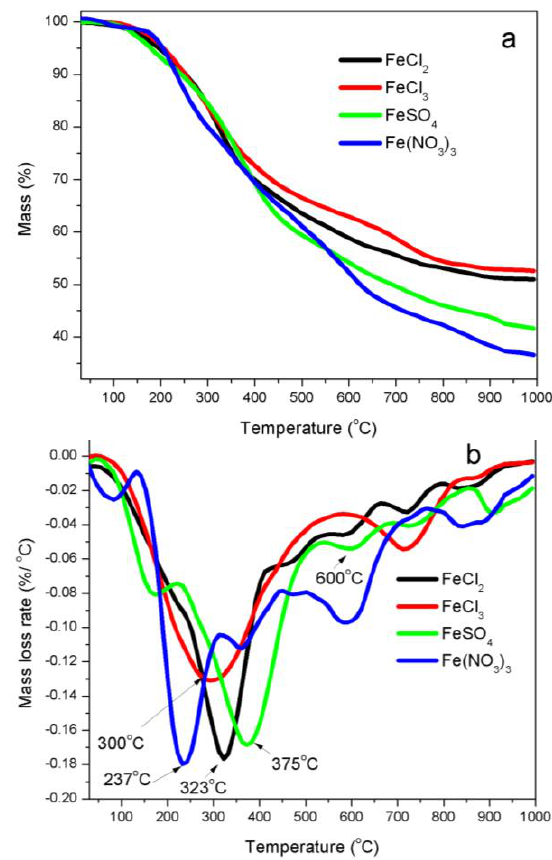
Figure 1. TG ( a ) and DTG ( b ) curves of kraft lignin promoted with four iron salts: FeCl 2 , FeCl 3 , FeSO 4 and Fe (NO 3 ) 3